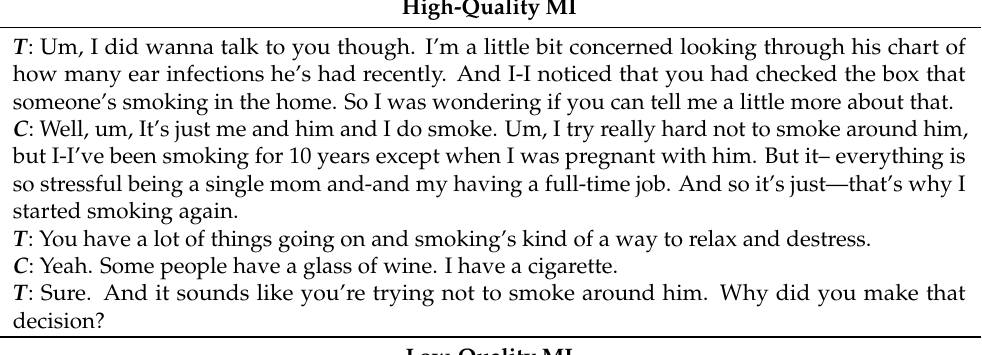
Table 1. High- and low-quality MI conversation snippets, where the goal is smoking cessa- tion/reduction. T : therapist; C :